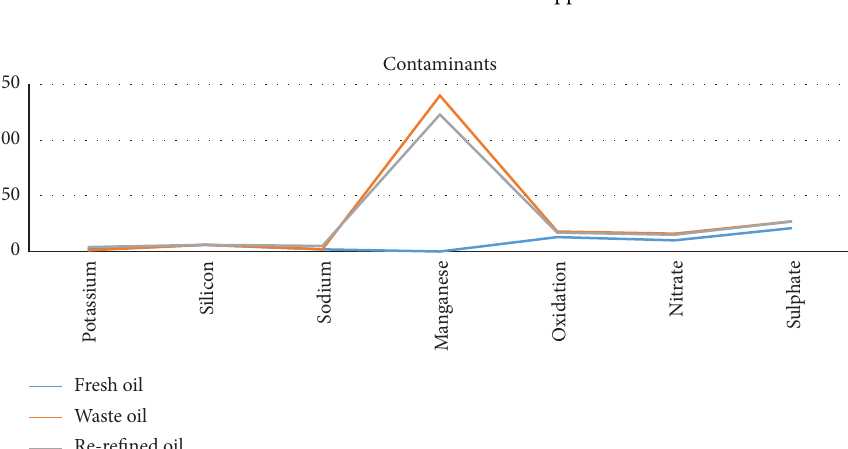
Figure 9: Wear metal content in ppm.